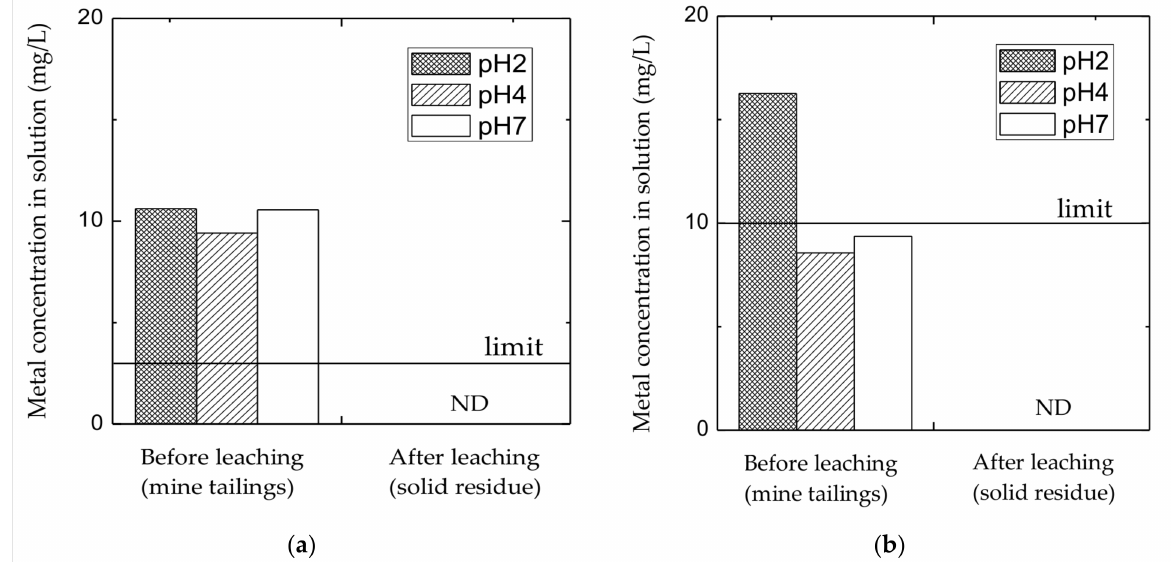
Figure 7. Metal concentration in the solution obtained from the elution test of mine tailings (before leaching) and solid residue (after leaching): ( a ) copper; ( b ) iron. ND = not